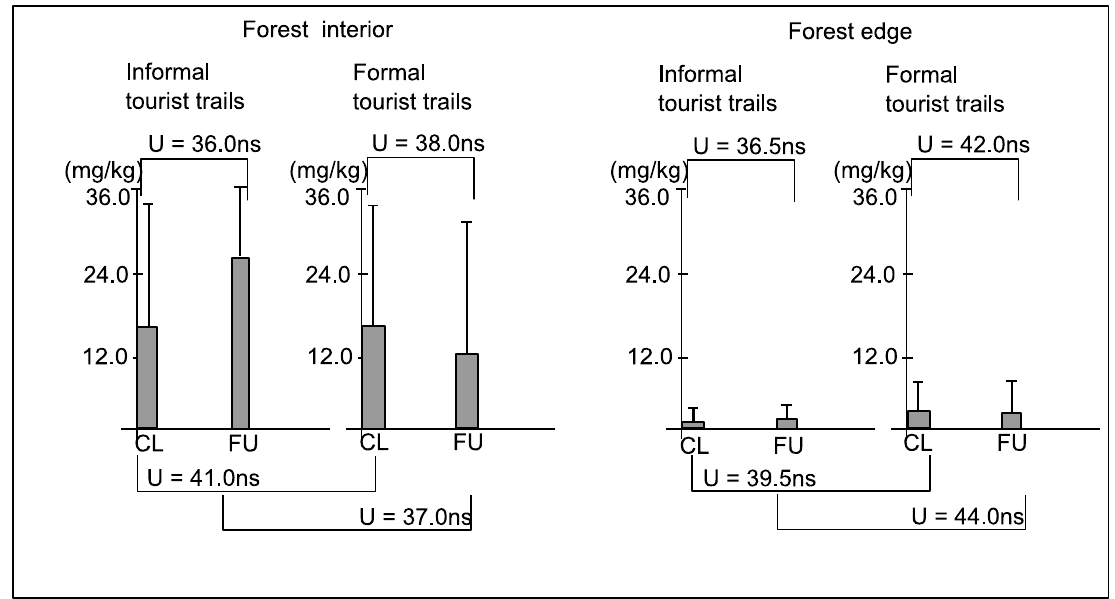
Figure 4. The mean content of ammonium nitrogen (N-NH 4 ) in mg/kg (±SD) in soil samples of closer (CL) and further (FU) plots located along informal (width < 50 cm) and formal (width > 150 cm) tourist trails within the forest interior and forest edge sites. The statistical significance level is explained in Figure 2.